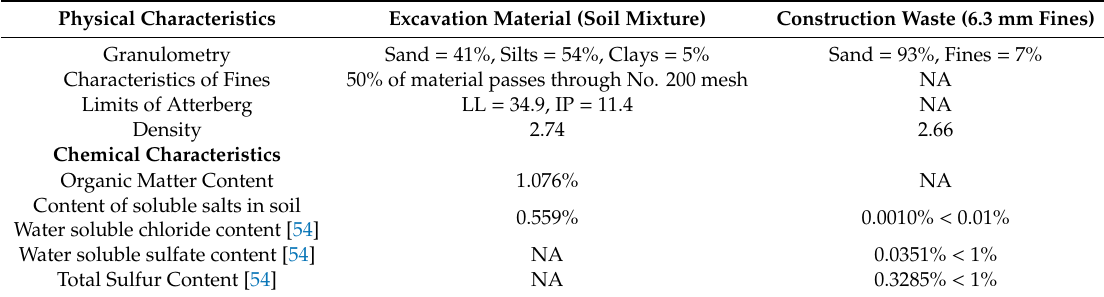
Table 9. Characteristics of the excavation material and construction waste.